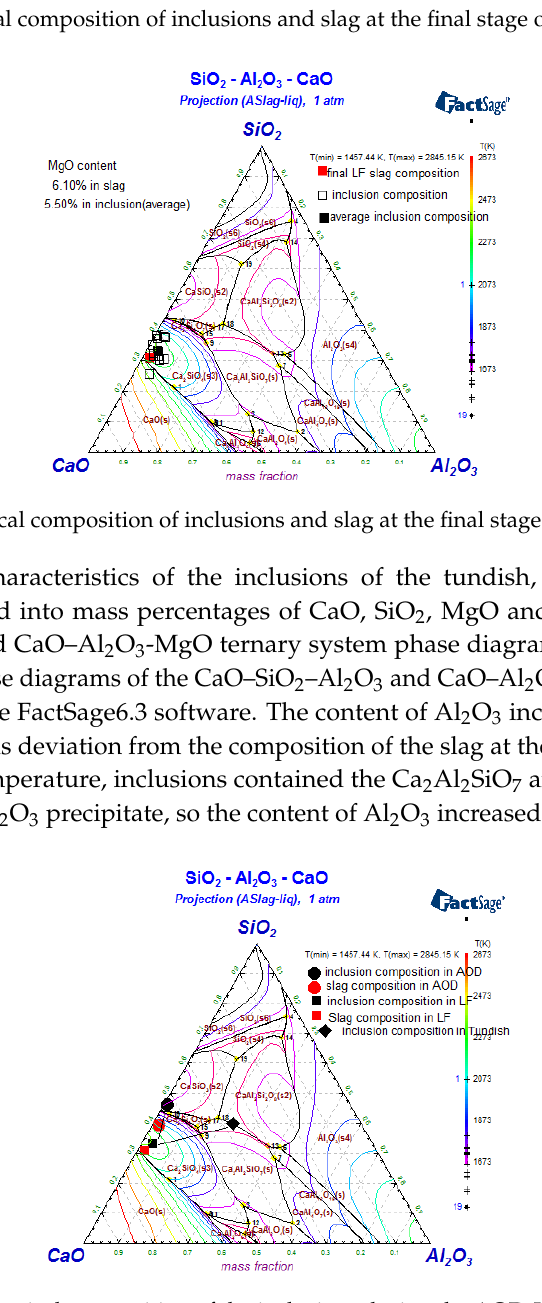
Figure 7. Chemical composition of the inclusions during the AOD-LF-CC